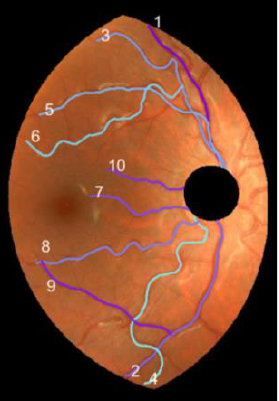
Figure 6. Vessel segments (1, ..., 10) selected in DR2.